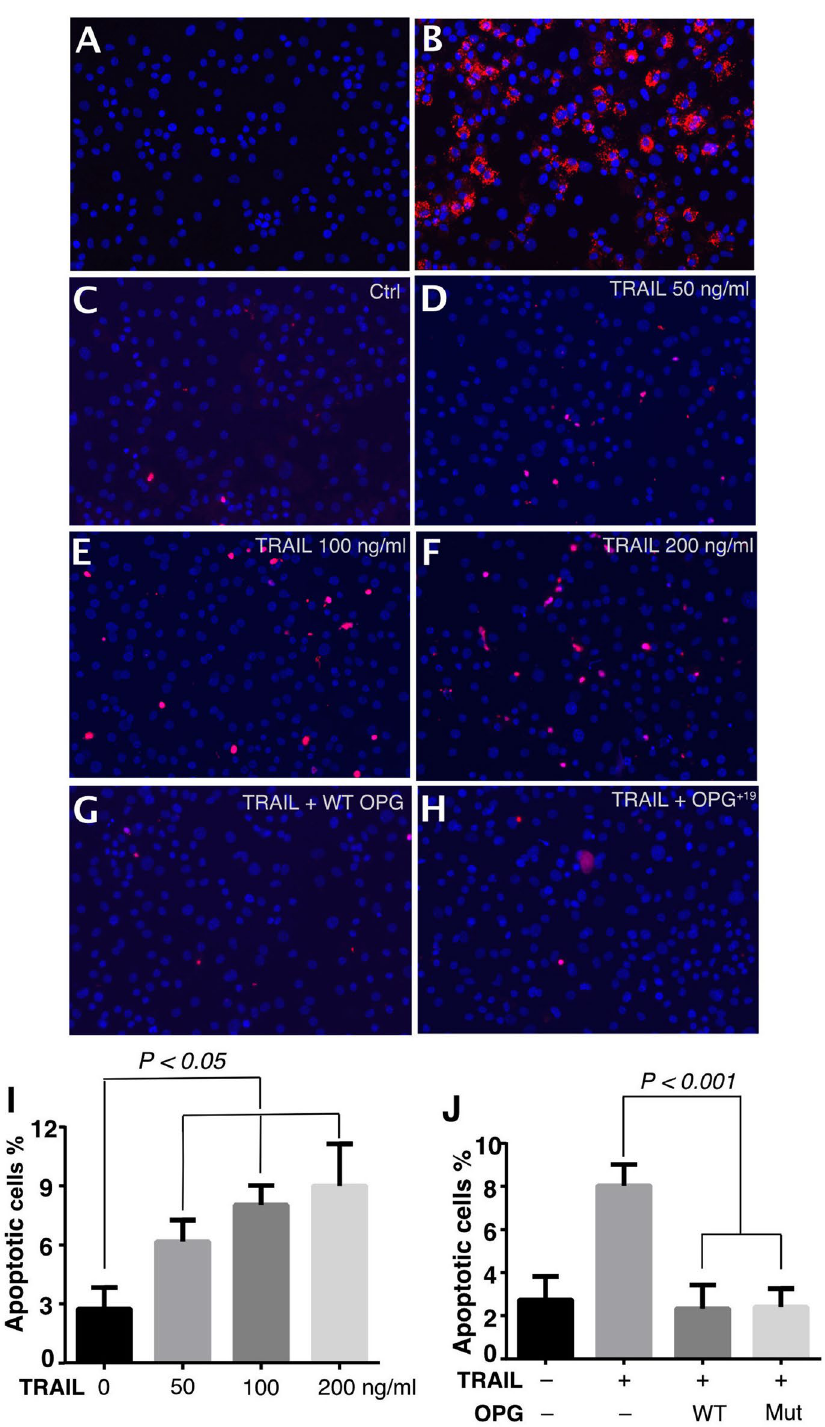
Figure 5. Both WT and mutant OPG inhibit TRAIL-induced chondrocytes apoptosis. ( A ) Primary murine articular chondrocytes were confirmed by Collagen II staining with a mouse anti-Collagen II monoclonal antibody, followed by anti-mouse Alexa594. ( B ) Chondrocyte were incubated with control mouse IgG2, followed by anti-mouse Alexa594. ( C–F ) TUNEL staining of untreated chondrocytes ( C ), or chondrocytes treated with 50 ( D ), 100 ( E ) and 200 ng/ml ( F ) of TRAIL. Apoptotic cells were stained red. Nuclei were stained blue with DAPI. ( G–H ) TUNEL staining of chondrocytes co-treated with 100 ng/ml TRAIL and 400 ng/ml WT ( G ) or mutant hOPG ( H ). ( I ) Quantification of the extent of chondrocytes apoptosis induced by TRAIL. ( J ) Quantification of chondrocytes apoptosis when co-treated with TRAIL and WT or mutant